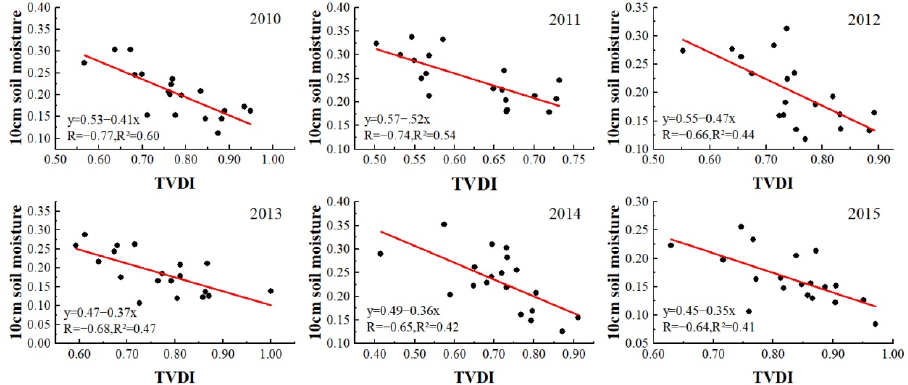
Figure 4. Correlation between TVDI retrieved by geomorphological division and 10 cm soil moisture in summer from 2010 to 2015 .